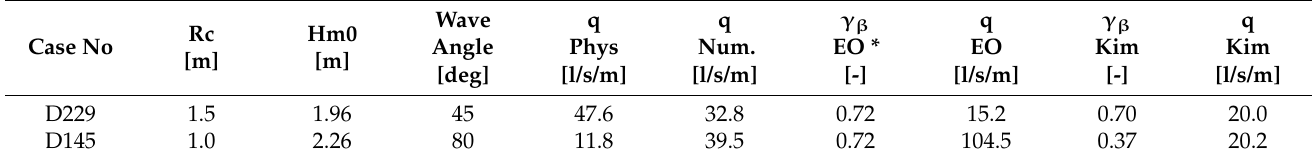
Table 2. Measured (physical model), simulated (numerical model) and estimated (EurOtop, Kim et al.) wave overtopping discharge (vertical structure, no